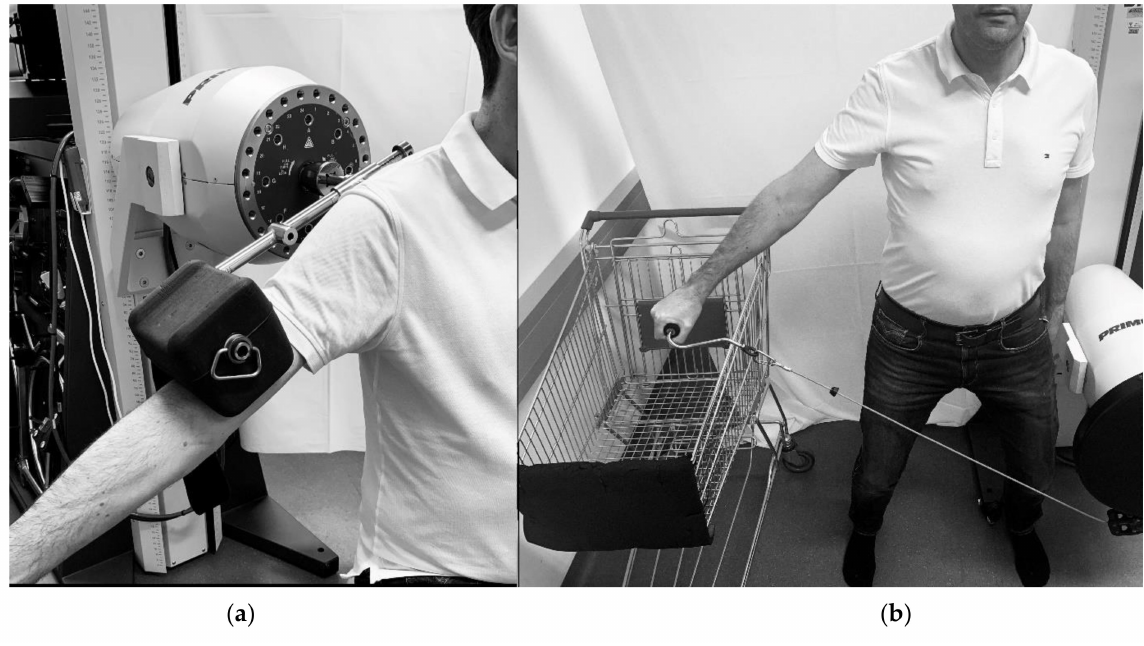
Figure 1. ( a , b ): Illustration of uniplanar and multiplanar movements: ( a ): uniplanar shoulder abduction; ( b ): multiplanar movement loading a shopping